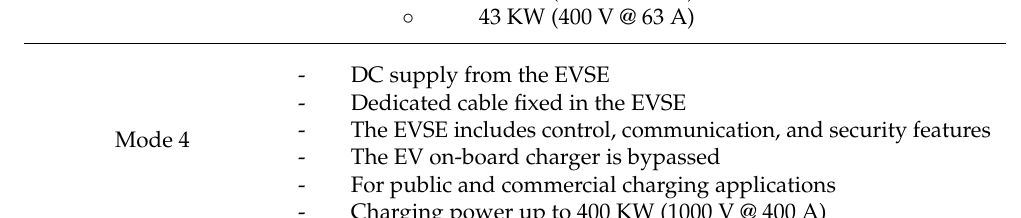
Table 3. Specifications of the IEC 61851 charging modes.